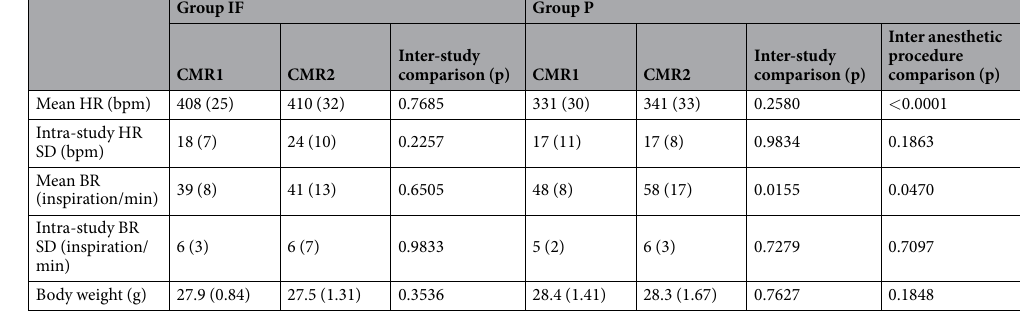
Table 1. Physiological parameters during cardiac magnetic resonance. Mean heart rate (HR), intra-study HR standard deviation (SD), mean breath rate (BR), intra-study BR SD and body weight during first (CMR1) and second (CMR2) cardiac magnetic resonance exams are presented for both anesthetic procedures (IF – isoflurane and P – pentobarbital). Data are the mean (SD).